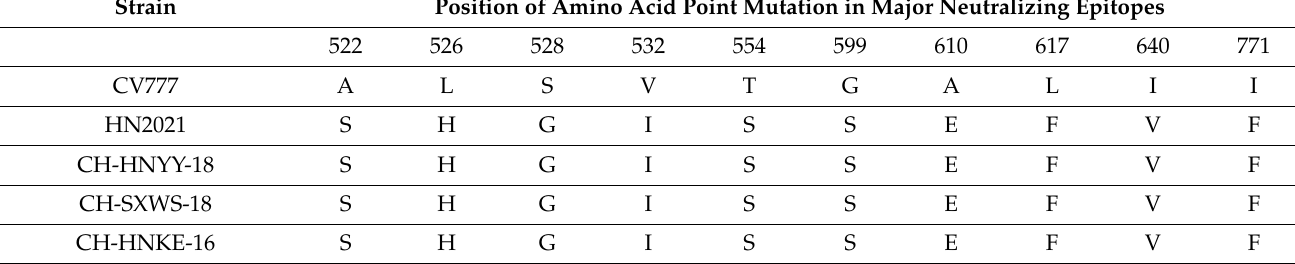
Figure 2. 3D structure prediction of PEDV S protein. ( a ) modelling the 3D structure of the S protein of CV777; ( b ) modelling the 3D structure of the S protein of HN2021.